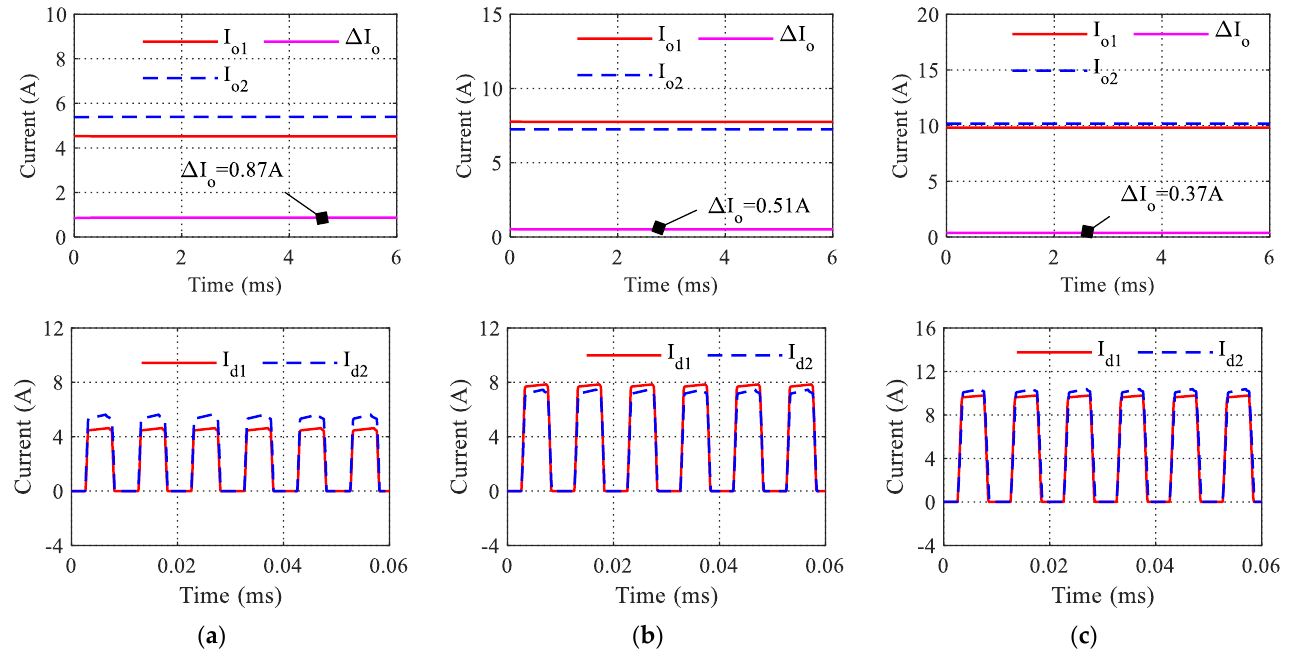
I and I in different P after only using calculation result o d o